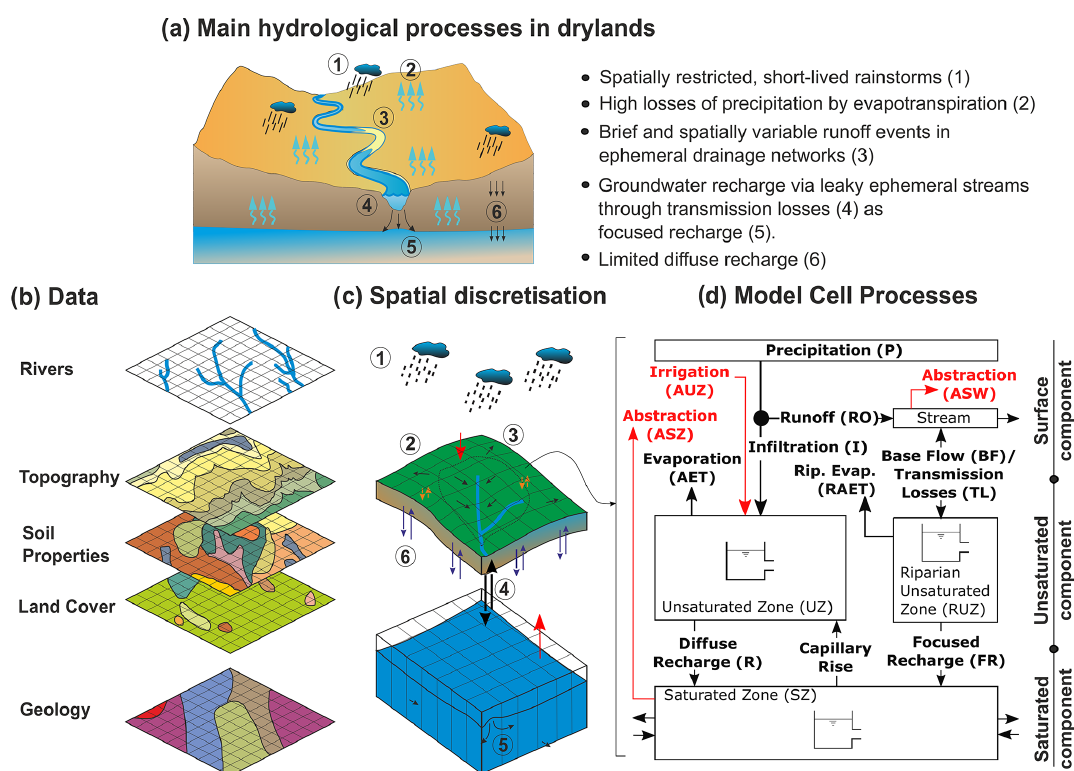
Figure 1. Schematic representation of DRYP showing (a) the main hydrological processes controlling water partitioning in dryland regions; (b) distributed data sets needed to derive input parameters; (c) vertical and horizontal discretisation and representation of topographically driven surface runoff, vertical flow in the unsaturated zone, and hydraulic gradient-driven groundwater flow in the saturated component; and (d) model structure and potential processes within a single grid cell for the surface component (see Sect. 2.2), unsaturated zone (see Sect. 2.3), and saturated zone (see Sect. 2.4). Arrows represent flow directions, and red lines represent anthropogenic